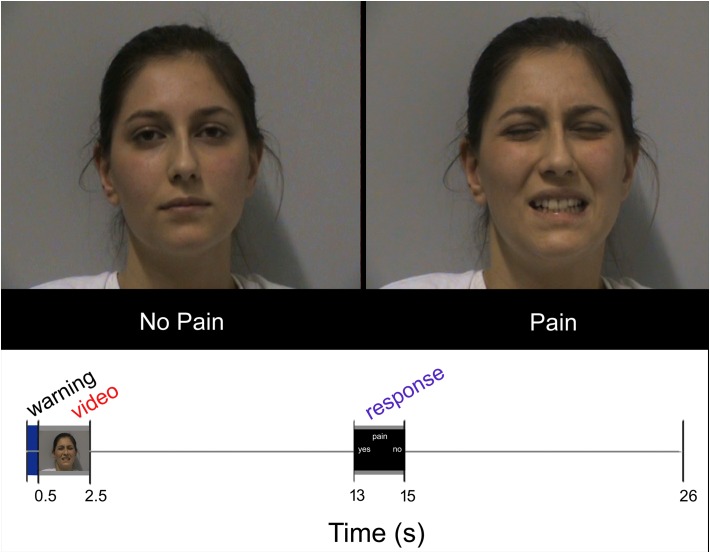
Top: Sample frames extracted from two video-clips representing NP and P stimuli, respectively. Bottom: Experimental design. Temporal sequence of events during each trial. Written informed consent was obtained from the pictured participant.